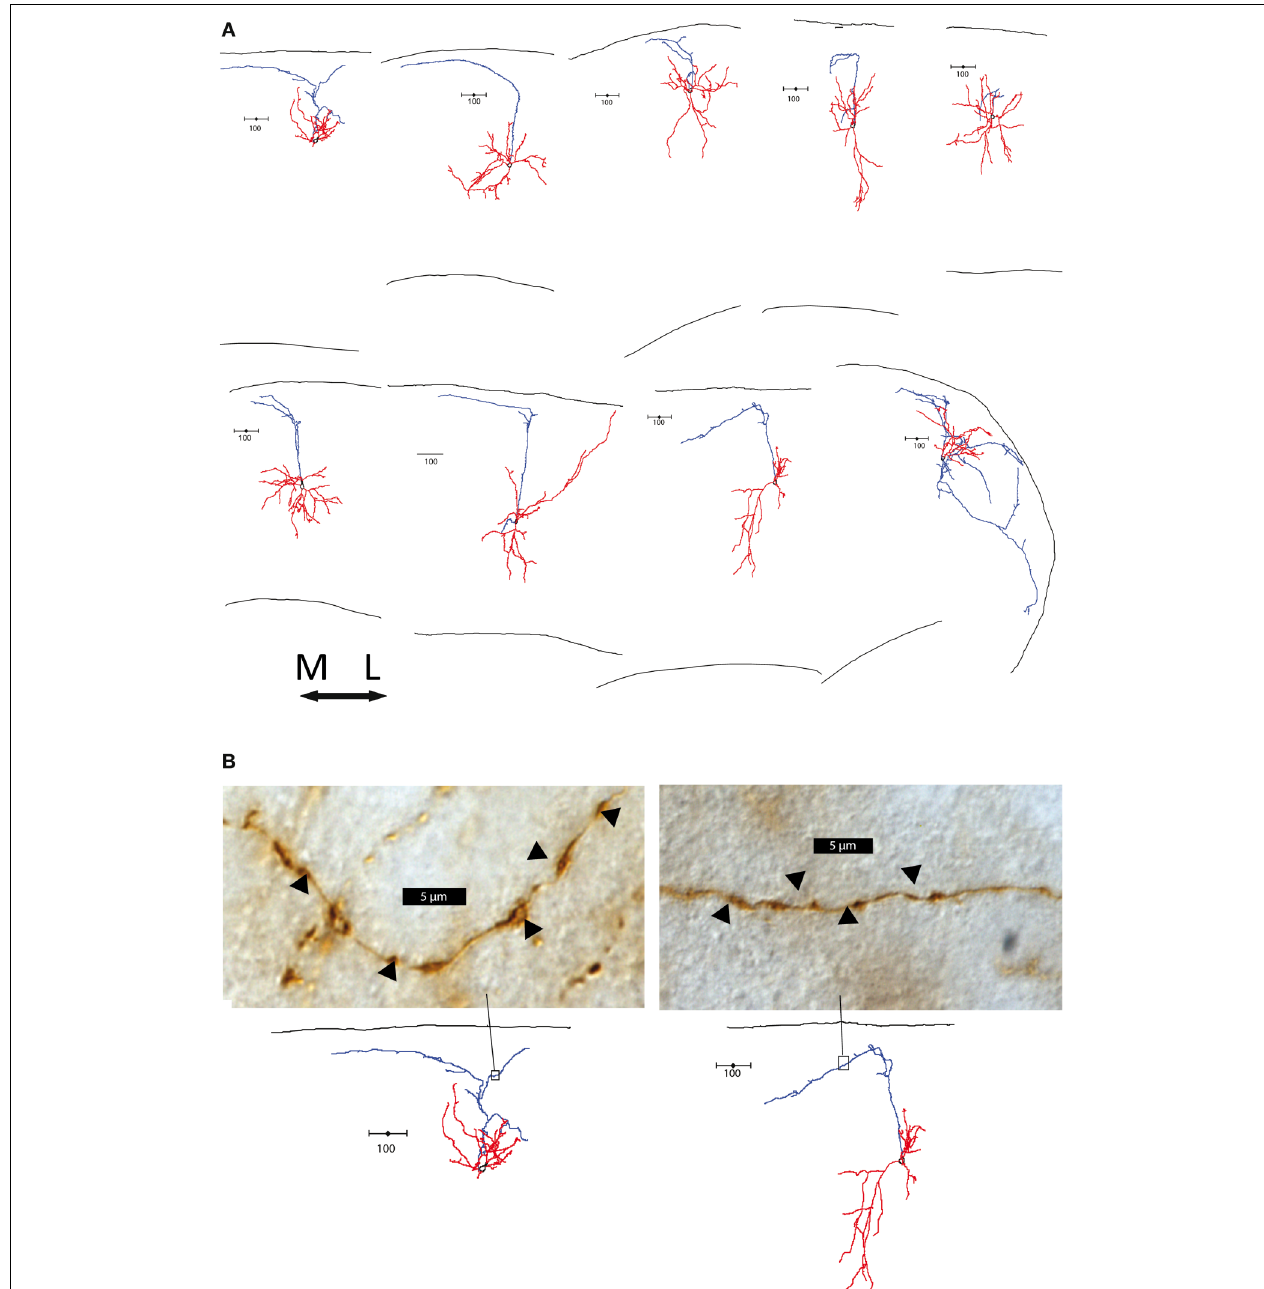
medially. (B) Light microscope images of section of two cells’ axons in the area boxed in the reconstructions below. Swellings in the axon indicated by arrow heads are possible boutons, found along the axons in layer